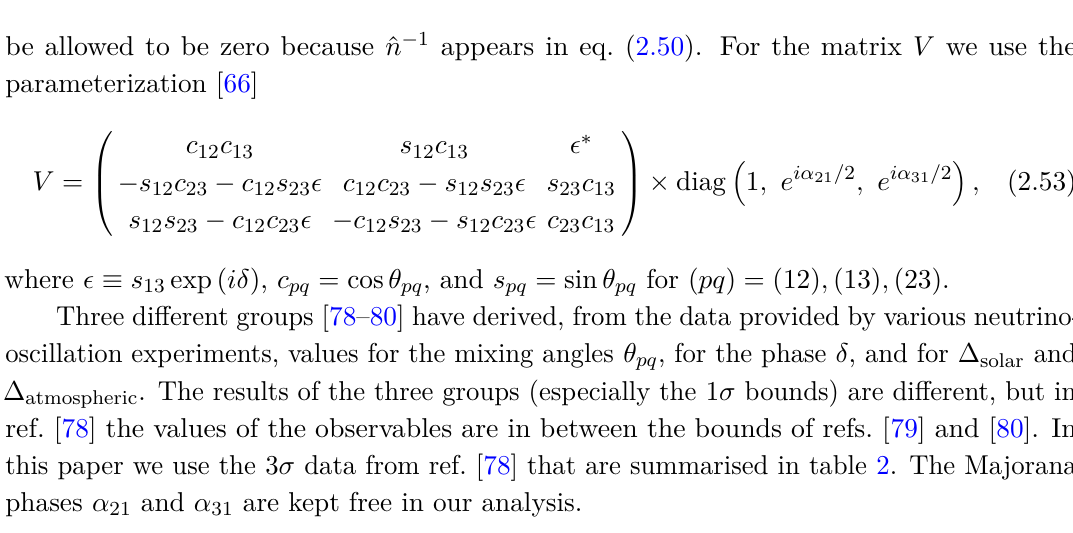
Table 2 . The neutrino-oscillation parameters used in our fits